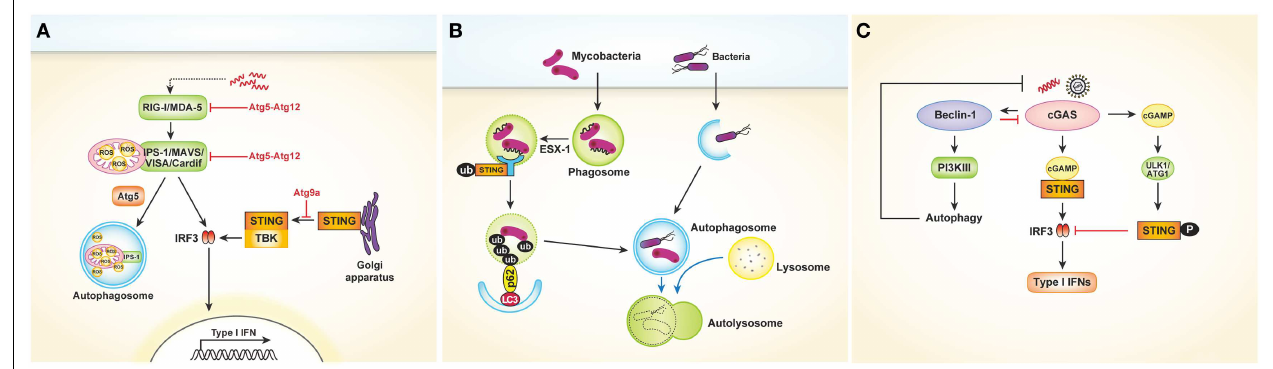
DNA, which is exposed to the host through ESX-1-mediated permeabilization of the phagosomal membrane, is recognized by the STING-dependent cytosolic pathway.The ubiquitinated bacterial DNA, which binds to the autophagosome-associated protein LC3 via adaptor protein p62 and NDP52, is targeted to the selective autophagy pathway. (C) Cytosolic DNA-sensing cGAS produces cGAMP, which binds to and activates the adaptor protein STING, thus leading to the production of type I IFNs. Direct interaction between cGAS and Beclin-1 suppresses cGAMP synthesis. Moreover, this interaction activates PI3K III-induced autophagy, enhancing the autophagy-mediated degradation of pathogen DNA. cGAMP generated by cGAS initially activate STING-dependent type I IFN responses. However, they subsequently trigger negative-feedback control of STING activity through phosphorylation of STING by serine/threonine ULK1